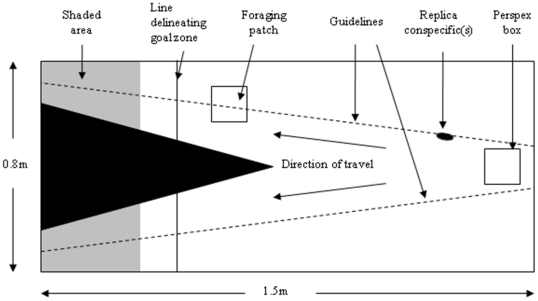
Experimental set-up.